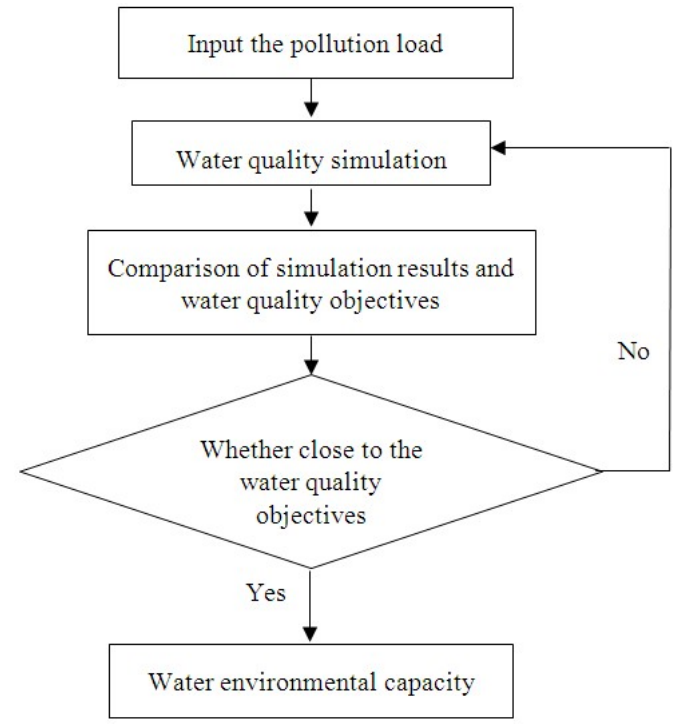
Figure 6. Schematic diagram of the trial and error